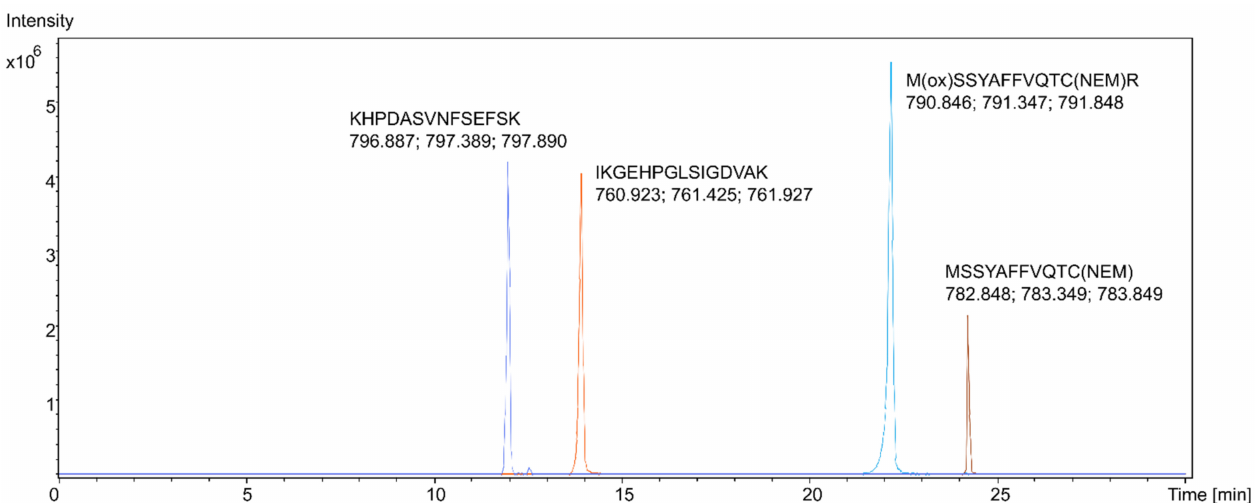
Figure 1. Reconstructed extracted ion chromatograms (EIC) for four specific high mobility group box 1 (HMGB1) peptides. The three masses for each peak represent the theoretical m / z of the peptide molecular ions [M + 2H] 2+ and the two most abundant 13 C isotope